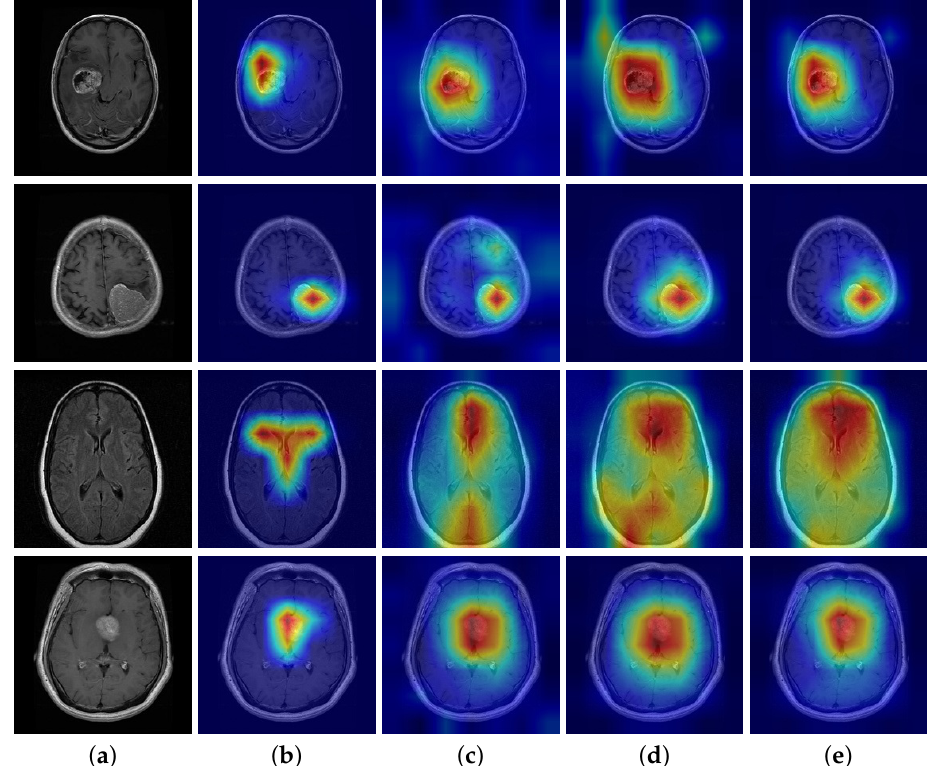
Figure 7. Class activation map (CAM) comparison with and without our modules in dataset BT-4C. Top to bottom : glioma, meningioma, normal, pituitary. ( a ) Original image, ( b ) CAM with GS module, ( c ) CAM without GS module, ( d ) CAM with LS module, ( e ) CAM without LS